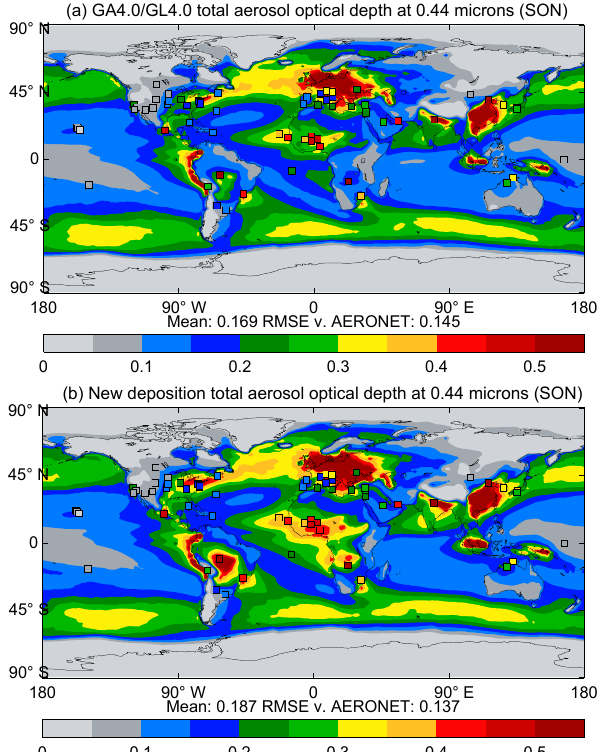
Figure 6. Mean total aerosol optical depth during SON from (a) a 10-year N96 atmosphere/land-only climate simulation using GA4.0/GL4.0 and (b) an equivalent simulation using z 0 , CLASSIC /z 0m 0 . 1 compared to climatological values from the AERONET sun photometer = network (filled squares in both